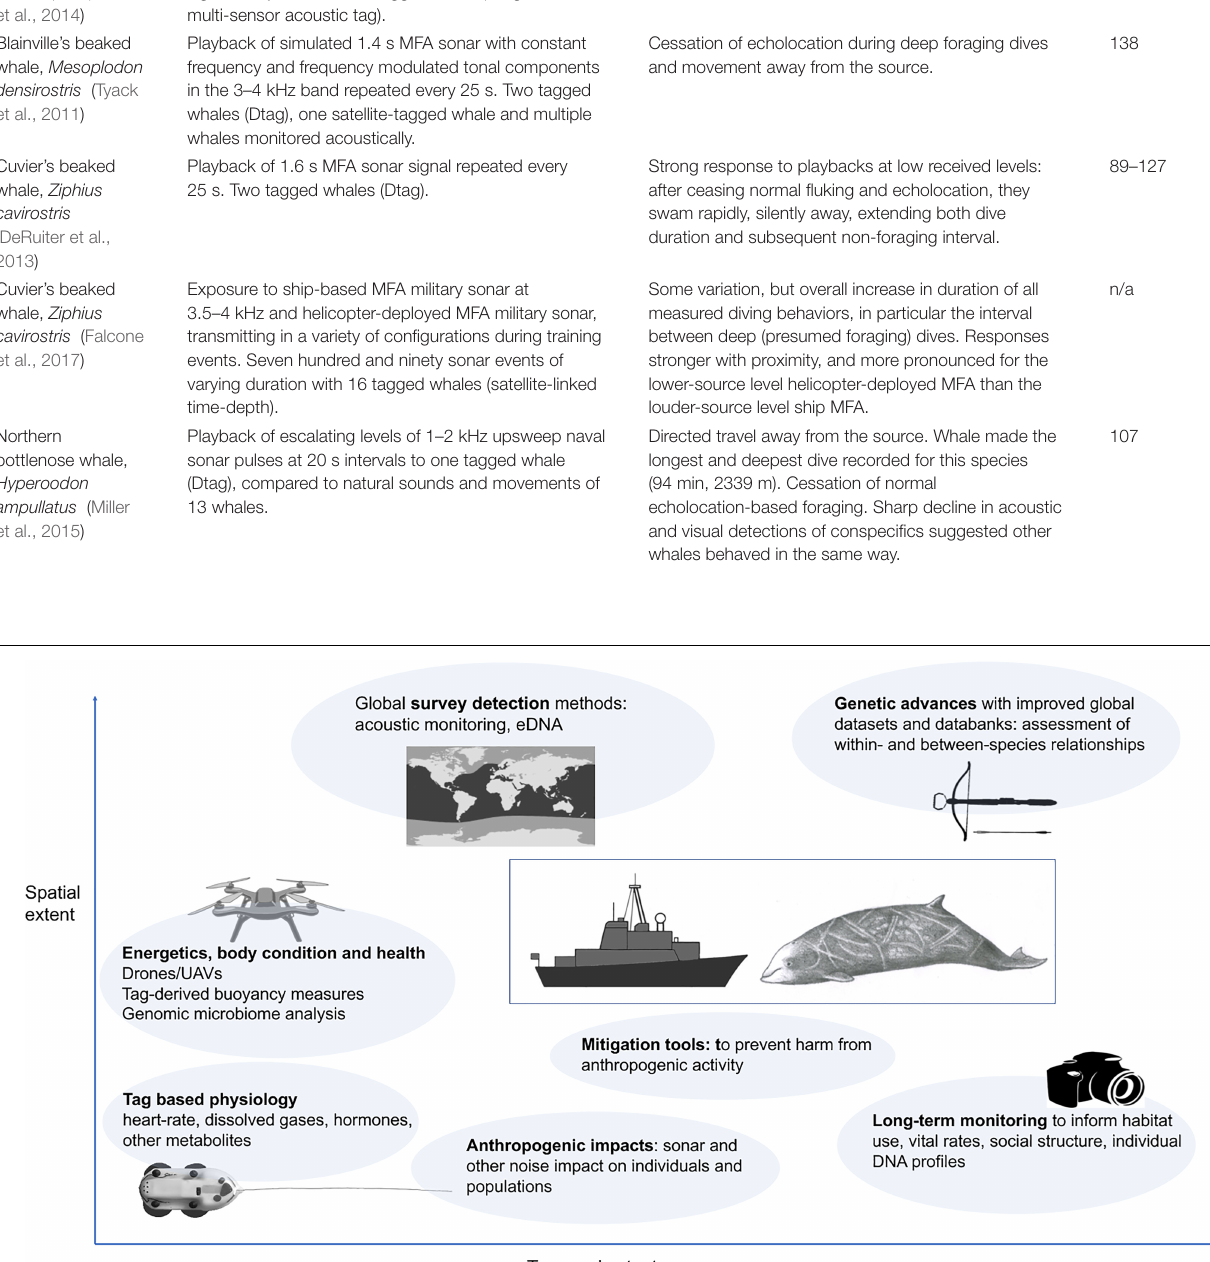
Frontiers in Marine Science |